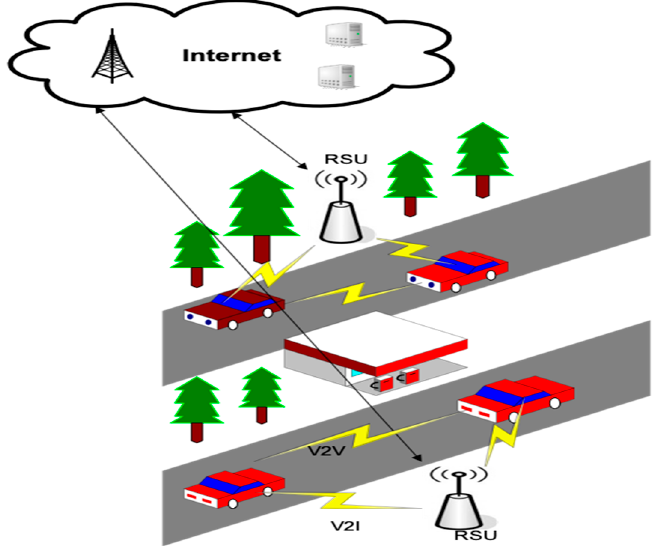
Figure 1. Dedicated Short Range Communication (DSRC) Architecture. RSU: Road Side Units; V2I: Vehicle to Infrastructure.